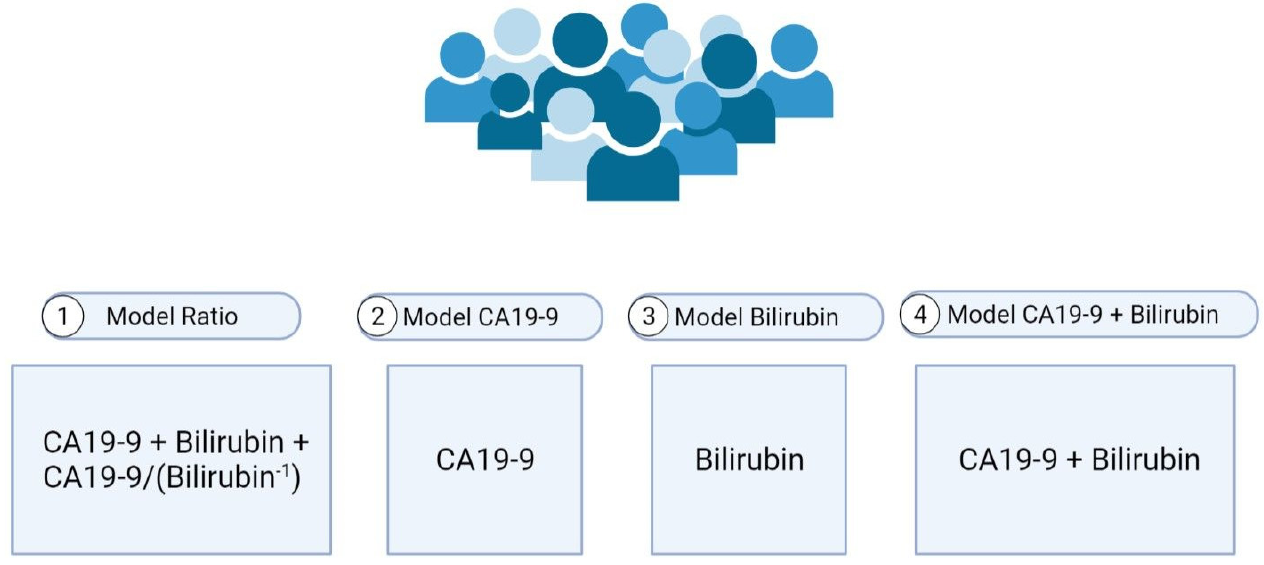
Figure 2. Four logistic regression models adopted in this Figure 2 . Four logistic regression models adopted in this study.